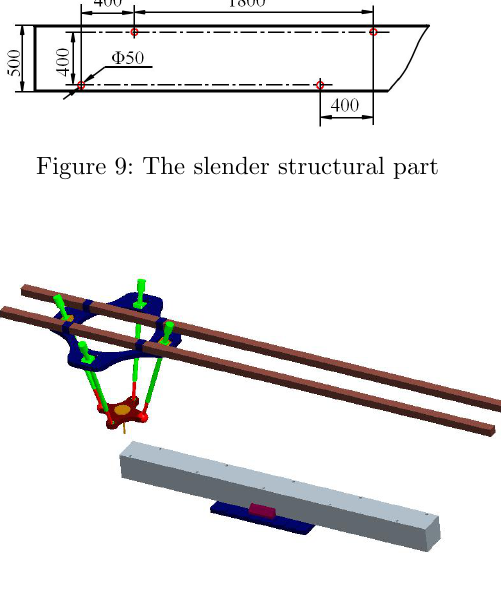
Figure 10: The machining simulation model